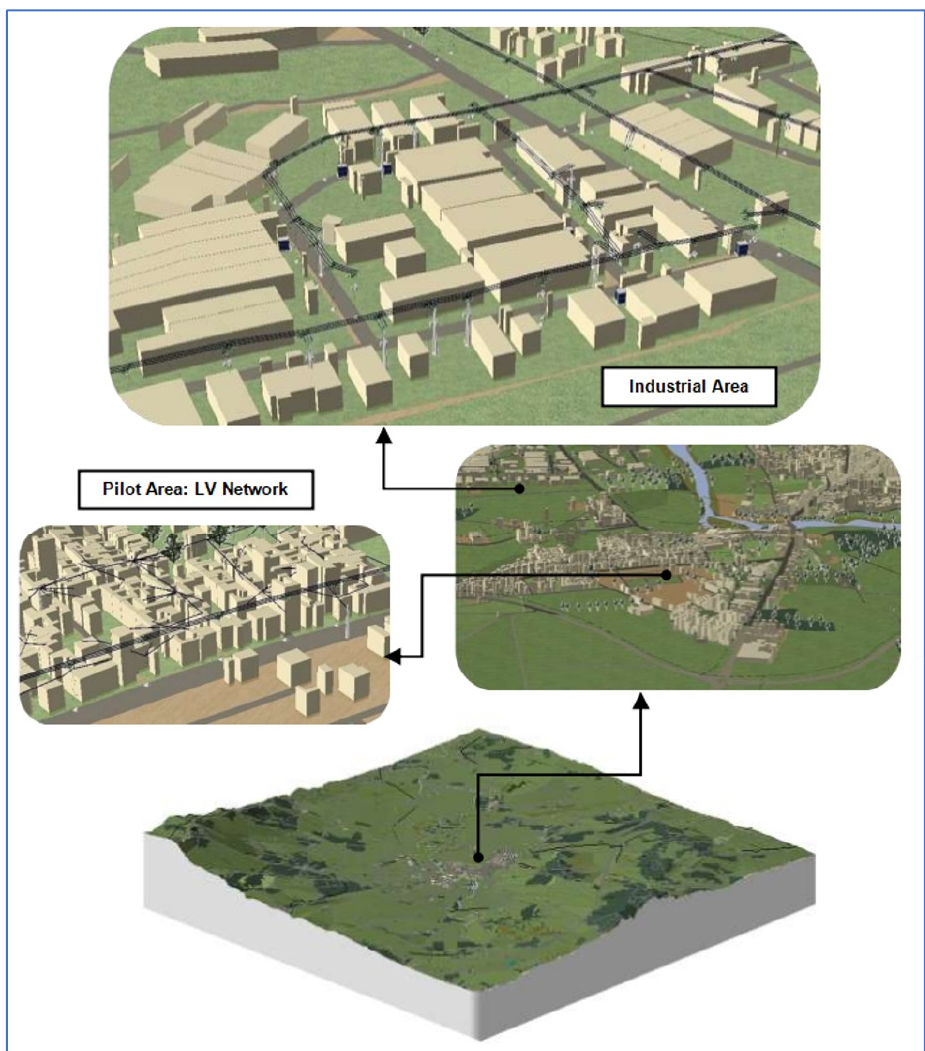
Figure 8. 3D model of the study area.